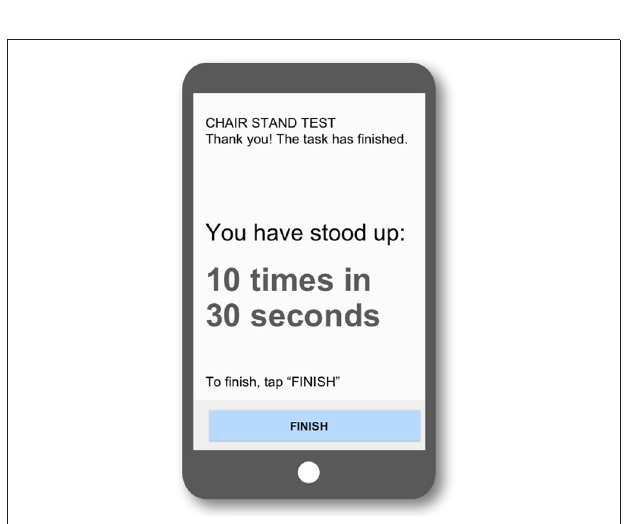
FIGURE 4 | Data capture app dashboard in the second test.